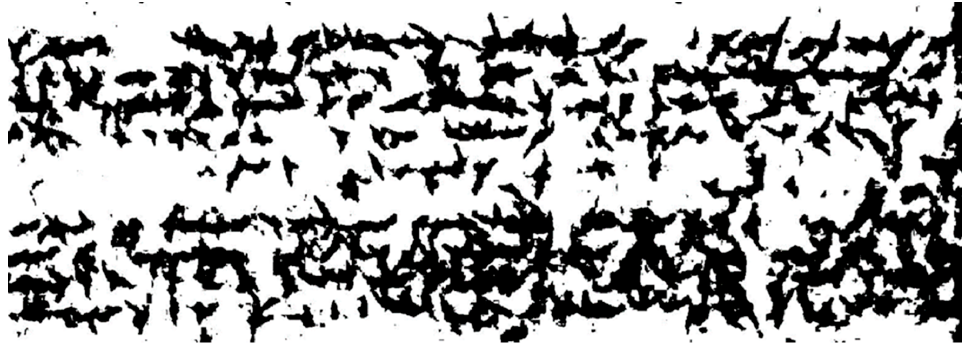
Figure 4. Example of ground cover segmentation of the green area. The black-filled area represents the amount of green pixels in the same plot as shown in Figure 2.